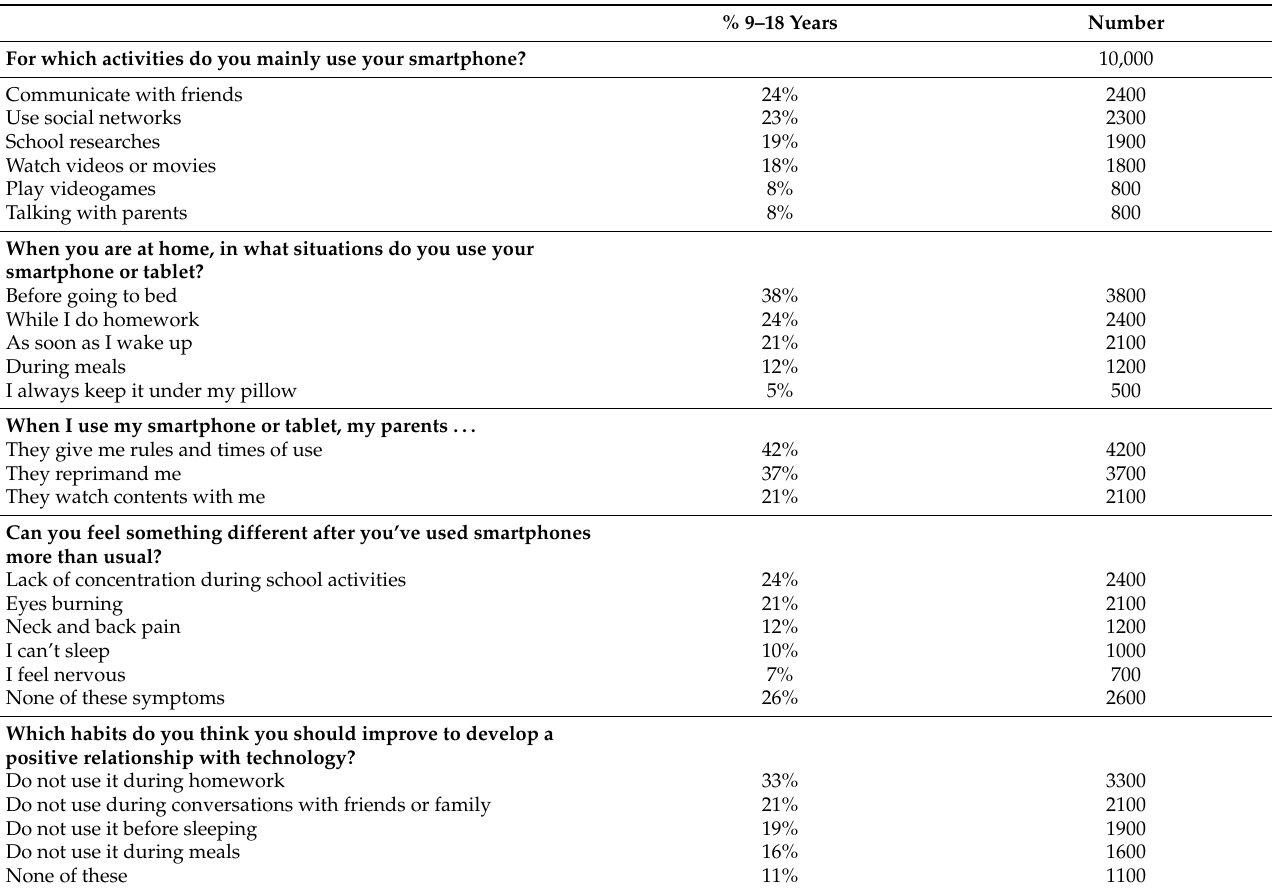
Table 3. Questionnaire about MD usage and perception among children and